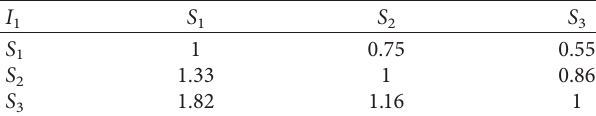
Table 5: Judgment matrix of the strategic layer relative to I